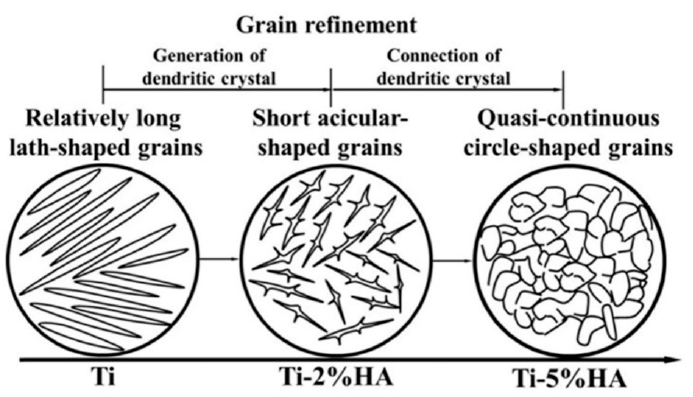
Figure 7. Schematic diagram of the microstructure evolution of SLM-processed Ti-nHA composites with different nHA addition [4].